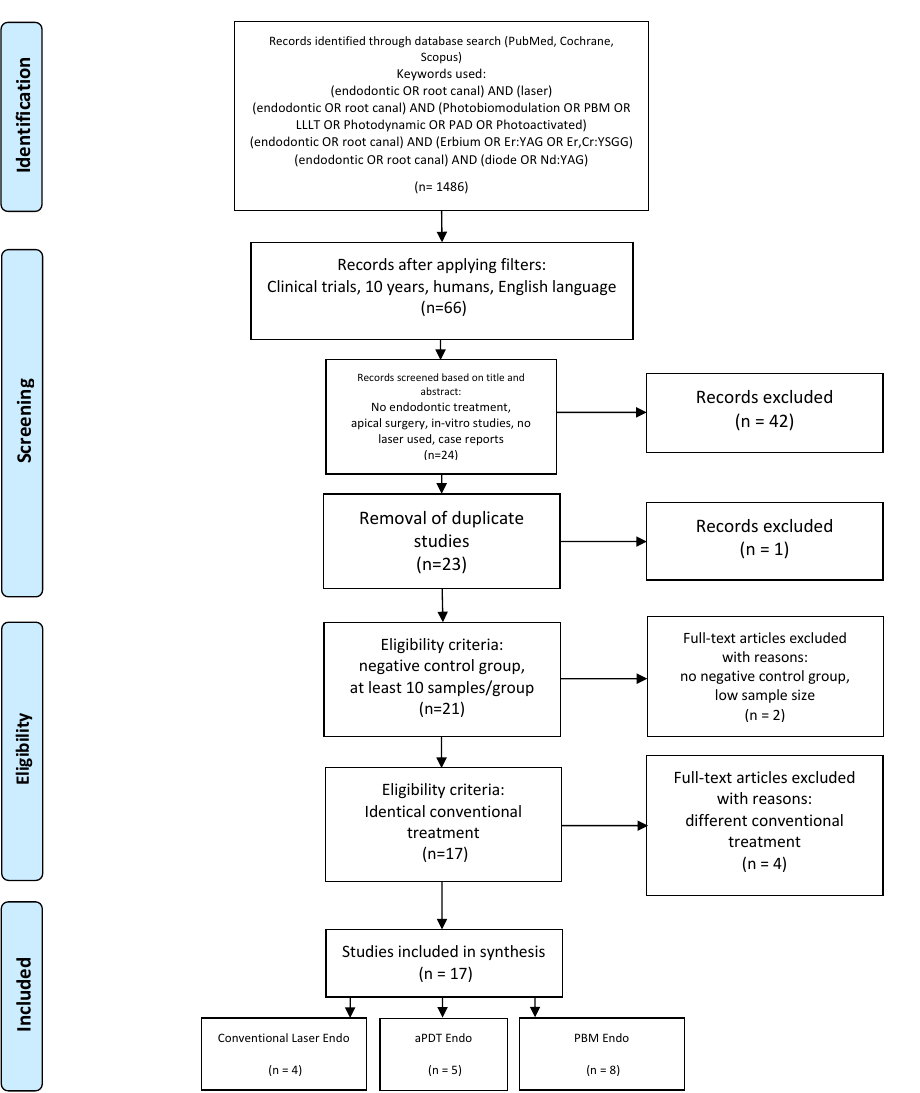
Figure 1. PRISMA flow-chart of selected criteria for the included article reports. (From: Moher, D.; Liberati, A.; Tetzla ff , J.; Altman, D.G.; Group, T.P. Preferred Reporting Items for Systematic Reviews and Meta-Analyses: The PRISMA Statement (Reprinted from Annals of Internal Medicine). PLOS Med . 2009 , 6 , e1000097, doi:10.1371 / journal.pmed.1000097.